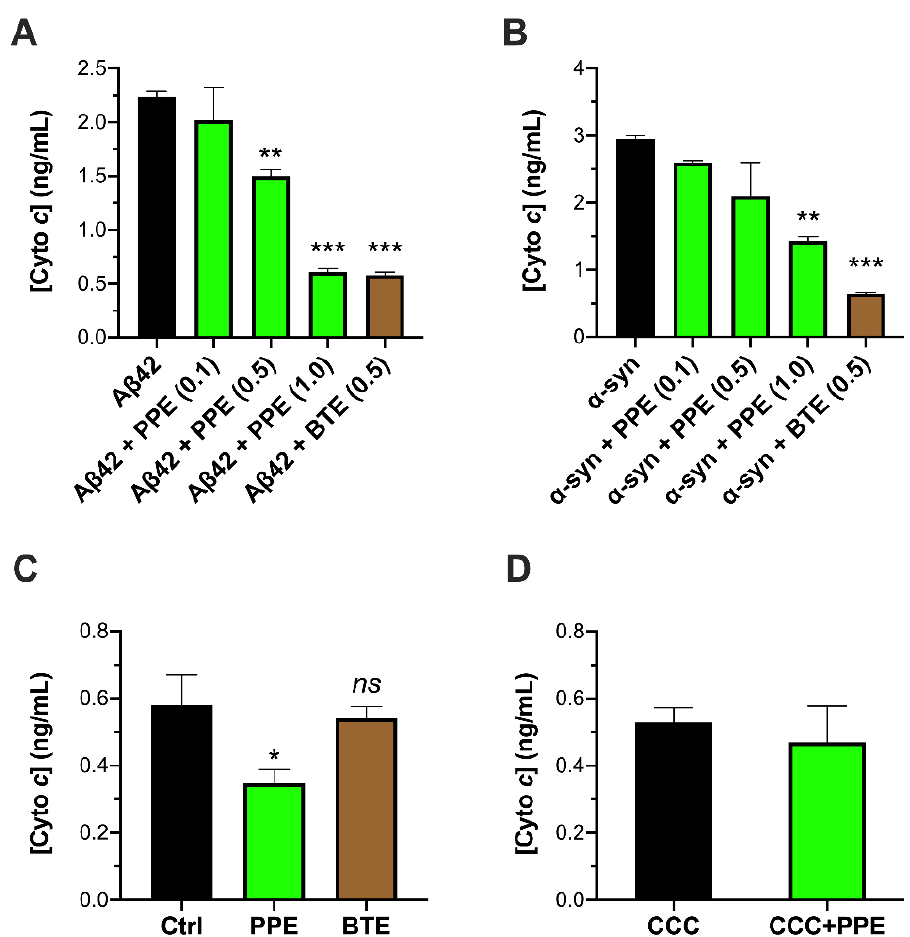
Figure 1. Inhibition of aggregate-induced cyto c efflux from isolated mitochondria. ( A , B ) Exogenous A β 42 (5 µ M) or α -syn (2 µ M) oligomers were added to freshly isolated mitochondria, following a 10-min pre-incubation of the oligomers with 0.01% DMSO (solvent control) alone and the extracts, PPE (0.1–1 µ g/mL) or BTE (0.5 µ g/mL). The concentration of cyto c in the supernatant released from the mitochondria was determined after 30 min in the presence of the A β 42 or α -syn oligomers. ( C ) Mitochondria were incubated with solvent control (Ctrl; 0.01% DMSO) alone, and with PPE or BTE (in the absence of aggregates). ( D ) To check for possible interference of PPE with the Quantikine ® assay, a known concentration of cyto c (0.4–0.6 ng/mL) was determined in the absence (CCC) and presence of 1 µ g/mL Padina extract (CCC+PPE). Values for cyto c concentration ([Cyto c ]) are presented as the means ± standard error of the mean (SEM) performed using duplicate readings ( n = 3–5). Significance was determined using one-way ANOVA. In ( A , B ), *** p < 0.001, ** p < 0.01, compared to A β 42 or α -syn alone. In ( C ), ns = not significant, * p < 0.05, compared to Ctrl. Refer to Suppl. Table S1 for F -values and p -values of one-way ANOVA.